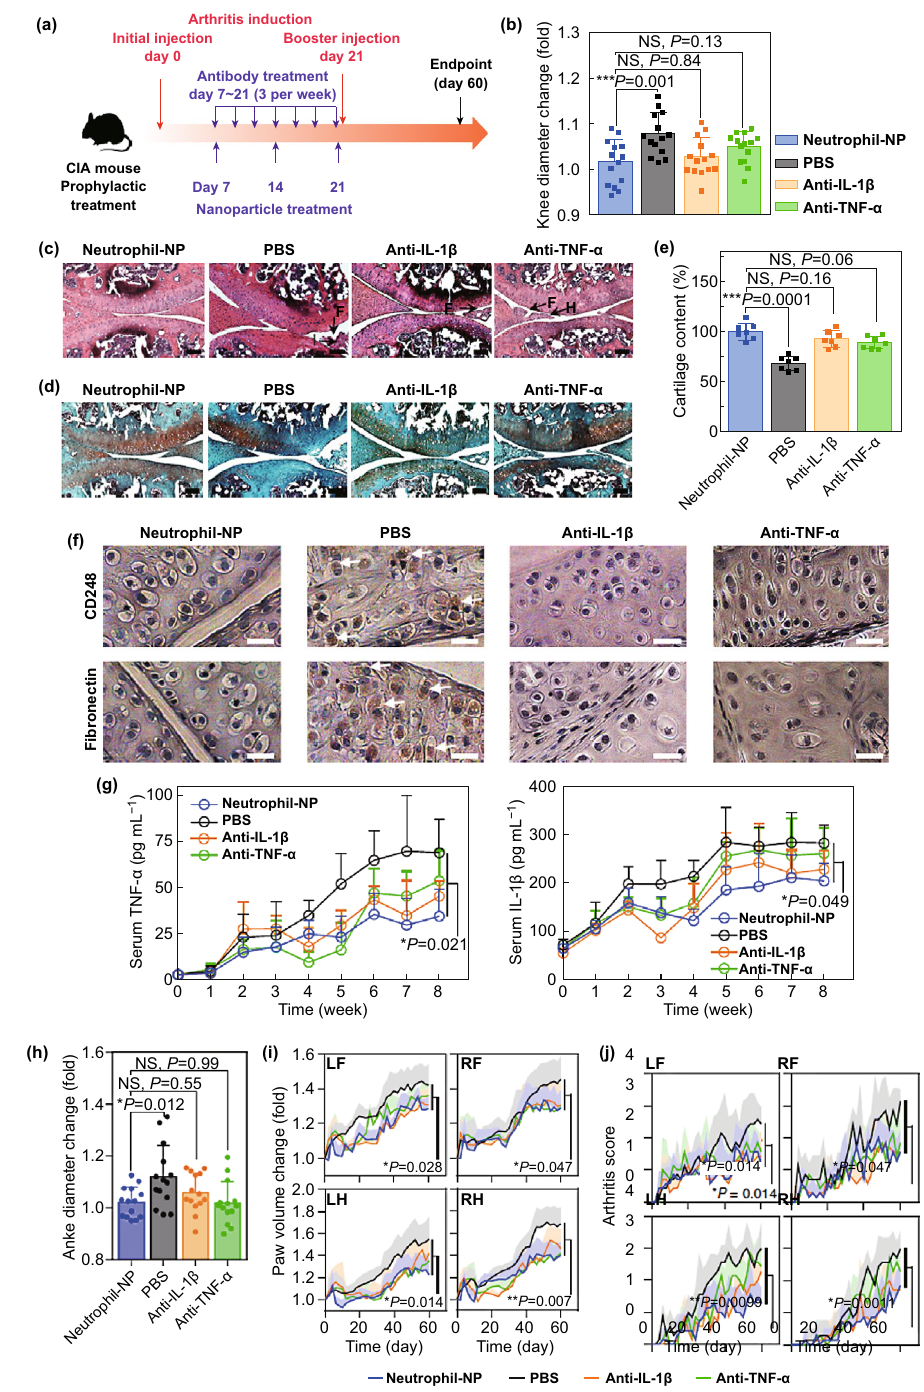
Fig. 11 Neutrophil‑NPs reduce joint destruction and elicit a systemic therapeutic response following a prophylactic regimen. a Overview of the prophylactic regi‑ men used in a CIA mouse model. b Changes in hind knee diameter over 60 days following CIA induction relative to day 0. c , d Representative H&E and safranin‑O staining of knee sections prepared from mice treated using PBS, neutrophil‑NPs, anti‑IL‑1β, or anti‑TNF‑α. Scale bar = 100 μm. F, synovial membrane fibrilla‑ tion; H, synovium hyperplasia; I, immune infiltration. e Quantification of cartilage levels in differently treated mice as measured in safranin‑O‑stained sections. f Representative CD248 (upper) and fibronectin (lower) staining of knee sections from differently treated mice. Scale bar = 10 μm. g Concentration of TNF‑α and IL‑1β in the serum of CIA mice in different groups. h Changes in hind ankle diameter on day 60 after arthritis induction compared to that on day 0. i , j Values of paw volume and arthritis score were recorded every other day for a total of 60 days. All data points represent mean ± S.D. ( n = 7 CIA mice). * p ≤ 0.05, ** p ≤ 0.01, *** p ≤ 0.001. One‑way ANOVA with Dunnett’s post hoc analysis. Adapted from Ref. [134] with